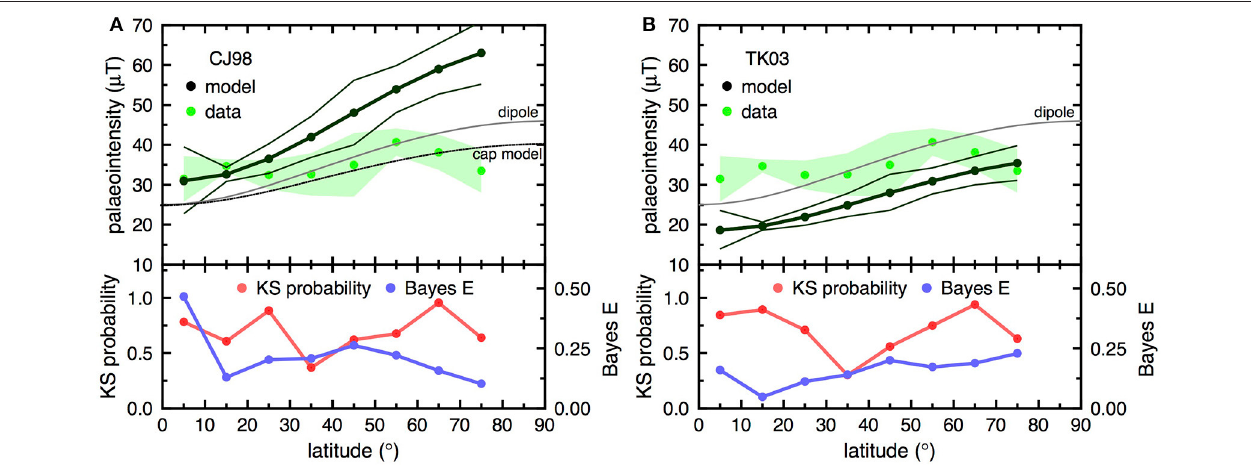
FIGURE 4 | GGP model intensity predictions vs. latitude for: (A) CJ98 model, and (B) TK03 model. Also depicted are palaeointensity data (green dots) from the PINT palaeointensity database (Biggin et al., 2009, http://earth.liv.ac.uk/pint), which has been binned at 10 ◦ degree intervals and the mean determined. The palaeointensity data were selected from the PINT database from sites ≤ 5Ma, for which there were at least three intensity estimates. The northern and southern hemisphere data are combined; there is no data > 80 ◦ . 95% confidence intervals are plotted for the PINT data (shaded green) and the model data (black lines). Additionally the standard dipole model (Equation1) is also calculated, with B D eq = 25 µ T (gray line), in (A) a cap model as shown in Figure 3 ( p max = 45 ◦ , p min = 20 ◦ ). In the lower section of the figures the Kolmogorov-Smirnov probability and the Bayes error E are plotted as a function of